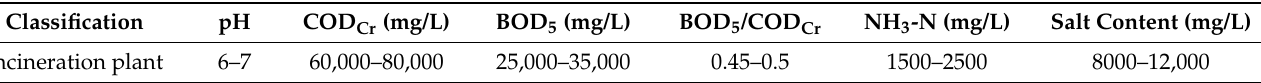
Table 3. Leachate characteristics from incineration power plants in China.